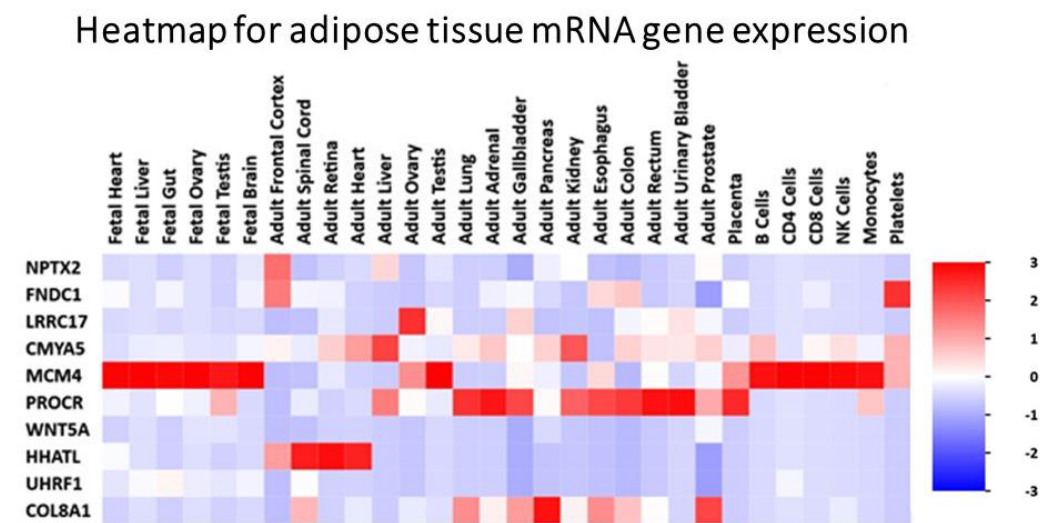
Figure 10. Heat map with differences in gene expression from adipose tissue signatures from the 20 genes identified as shown in Figure 9. Gene MCM4 shows “hot red” values perhaps indicating higher activity in several fetal pathways and, interestingly, from the immune systems through B cells, CDK4, CDK8, monocytes and NK cells.